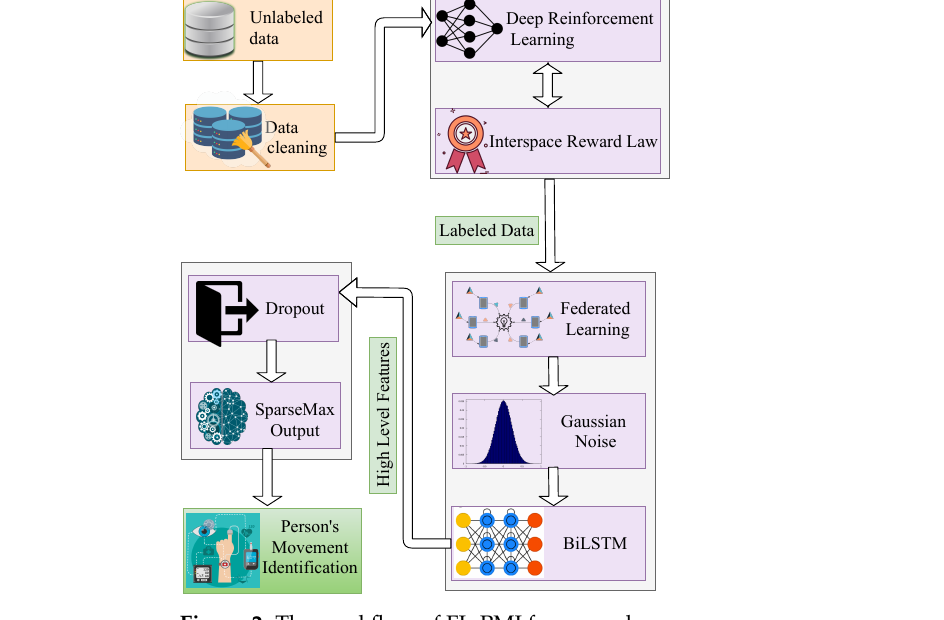
Figure 2. The workflow of FL-PMI